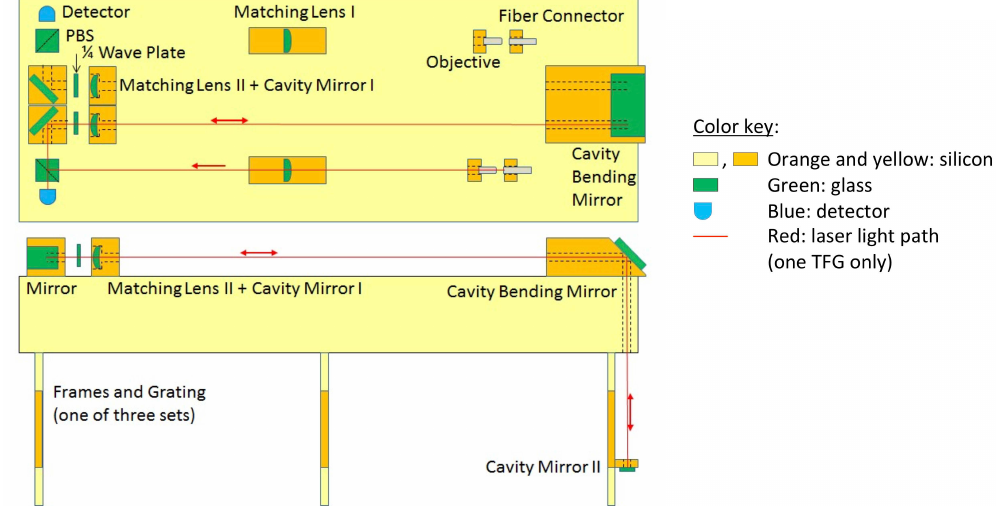
Figure 4. Optical layout concept of the two TFG measurement interferometers observing the position of grating 3, mounted on bottom outer surface of optical bench, in two orthogonal views, with one light path indicated in red. (Similar arrangements on the outer sides of the optical bench can monitor the alignment of the other two gratings.) The TFG is shown operating in a cavity, which enhances the performance over operation in a Michelson